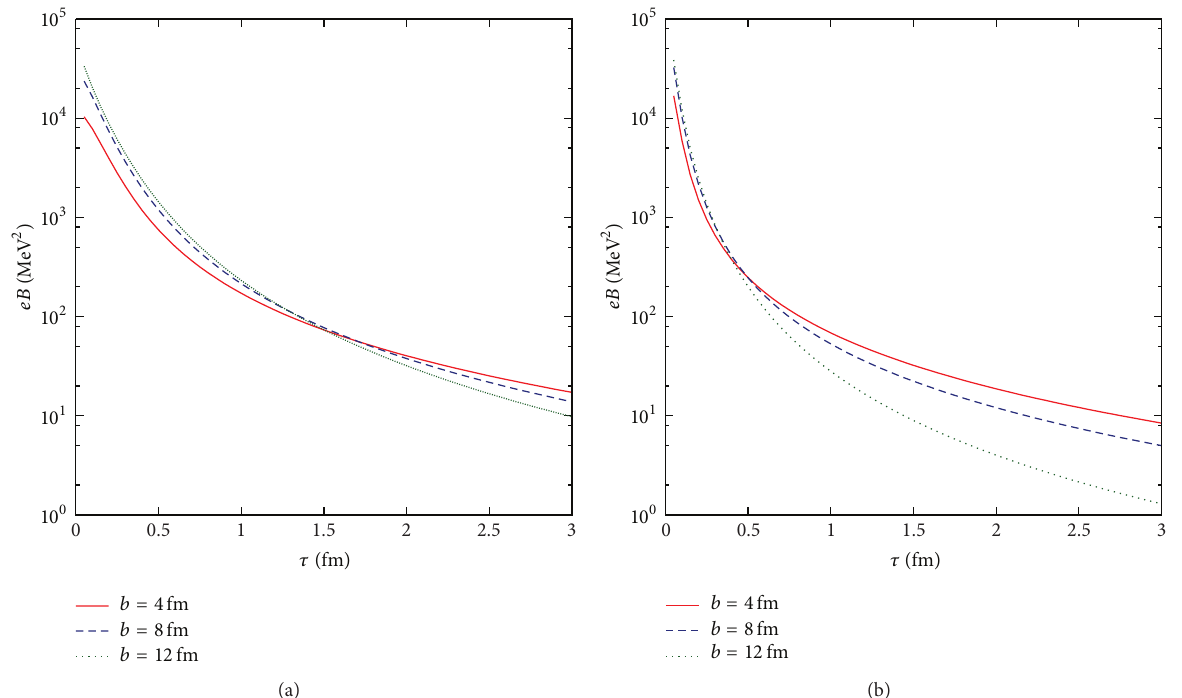
Figure 2: Magnetic field B = 𝐵̂ y (multiplied by 𝑒 ) at the origin r = 0 produced in collision of two gold ions at beam energies (a) √𝑠 𝑁𝑁 = = 200 GeV. Adapted from [5]. Note that 𝑒𝐵 is the same in Gauss and Lorentz-Heaviside units in contrast to 𝐵 . 62 GeV and (b) √𝑠 𝑁𝑁